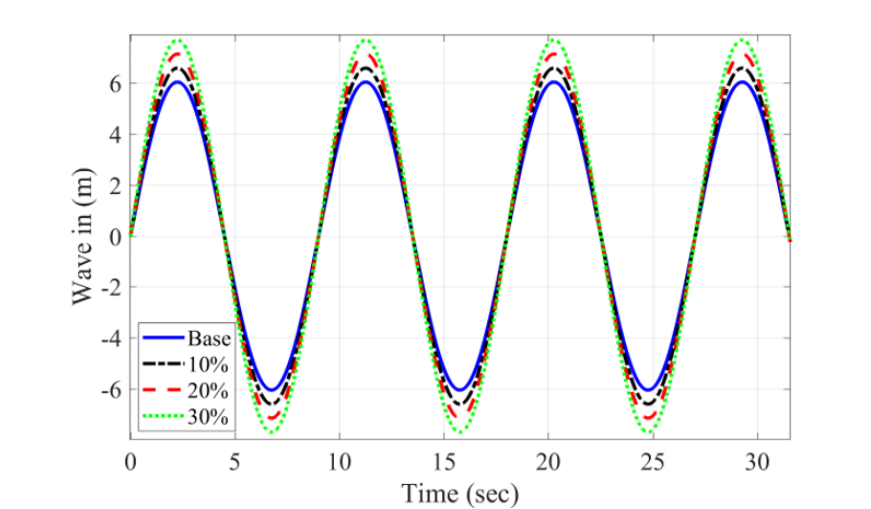
Figure 10. External wave input for the first 30 of 100 s duration.